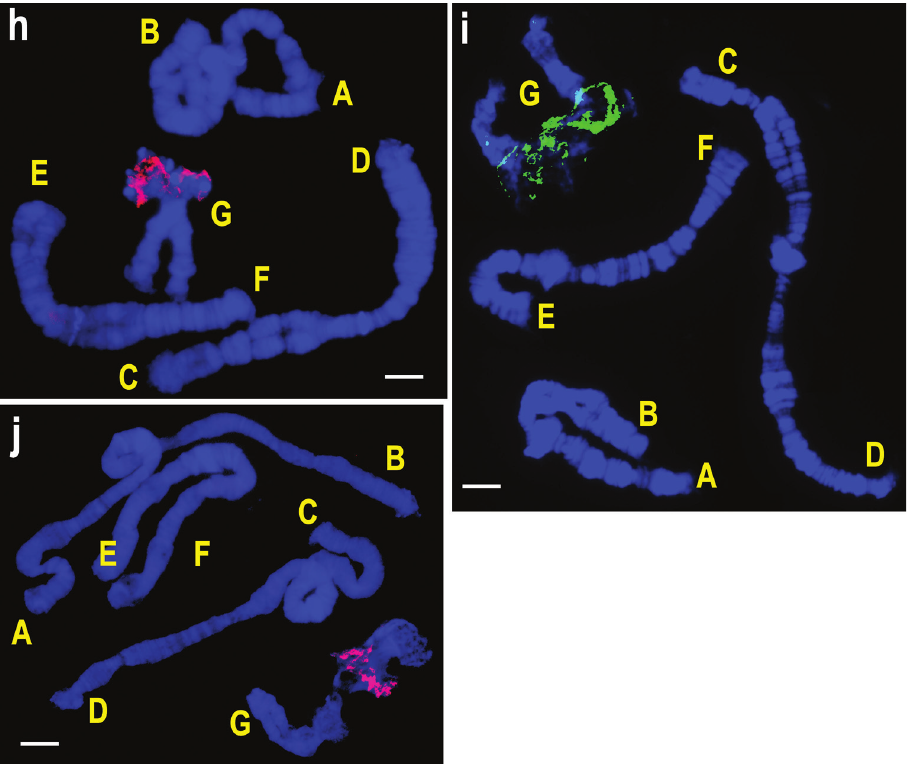
Figure 2. Continued. FISH of rDNA probes on polytene chromosomes of species from the subgenus Chironomus with one NOR in karyotype. h Ch. plumosus i Ch. sororius j Ch. riparius . Letters designate chromosomal arms. Bar = 10